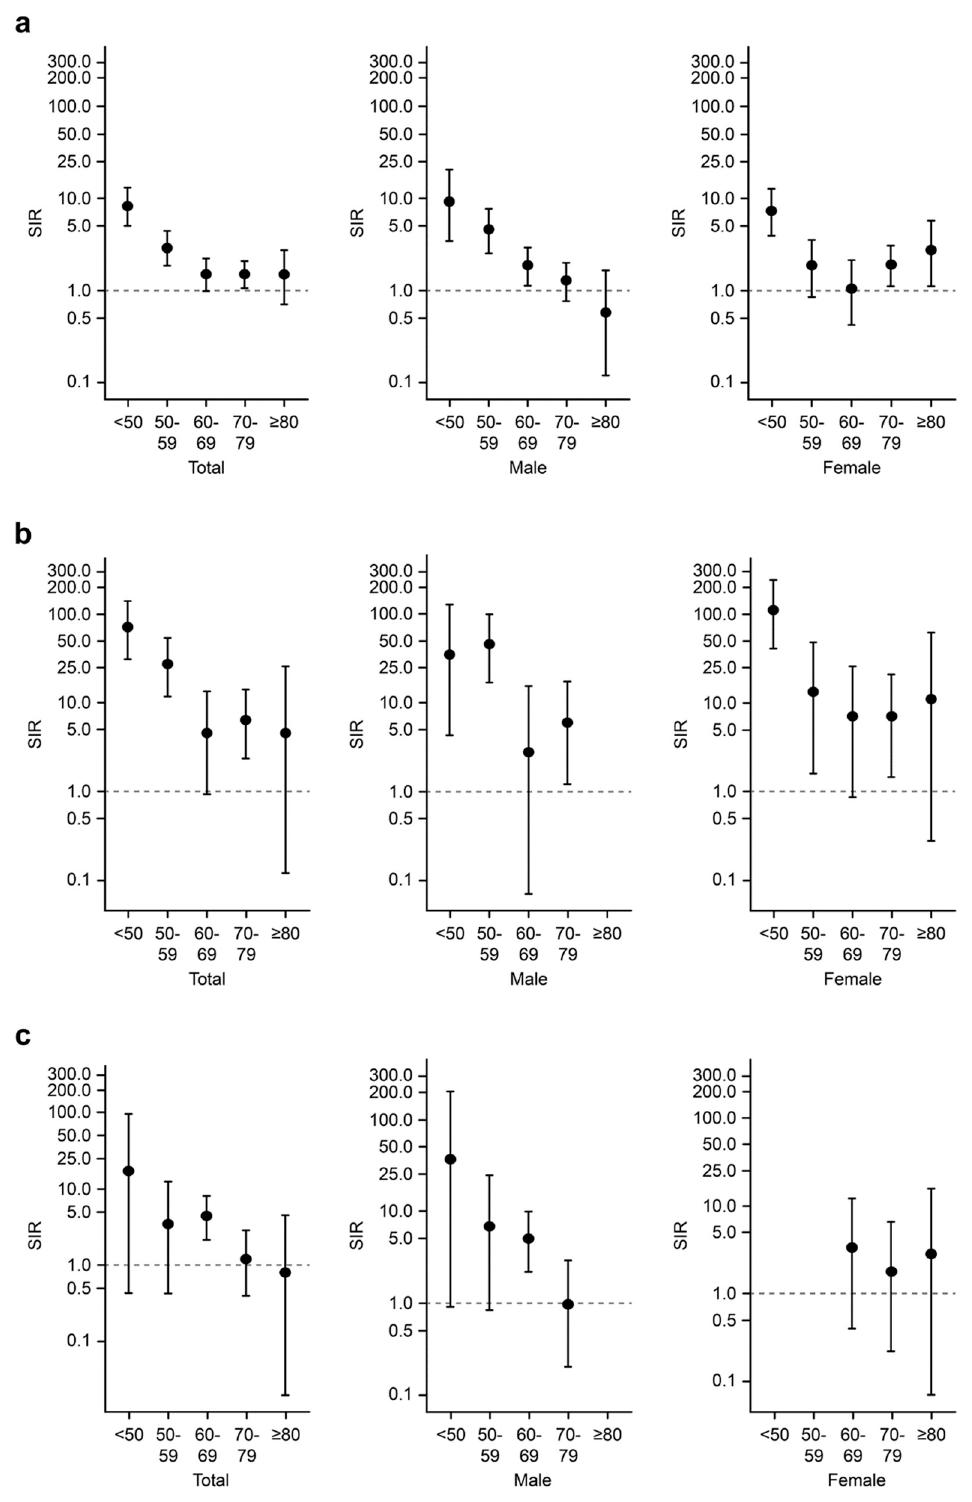
Figure 1. Risks of overall, hematologic, and lung cancers according to age groups. The standardized incidence ratios of ( a ) overall, ( b ) hematologic, and ( c ) lung cancers were assessed in the patients with AAV according to age groups. AAV: ANCA-associated vasculitis; ANCA: Antineutrophil cytoplasmic antibody.